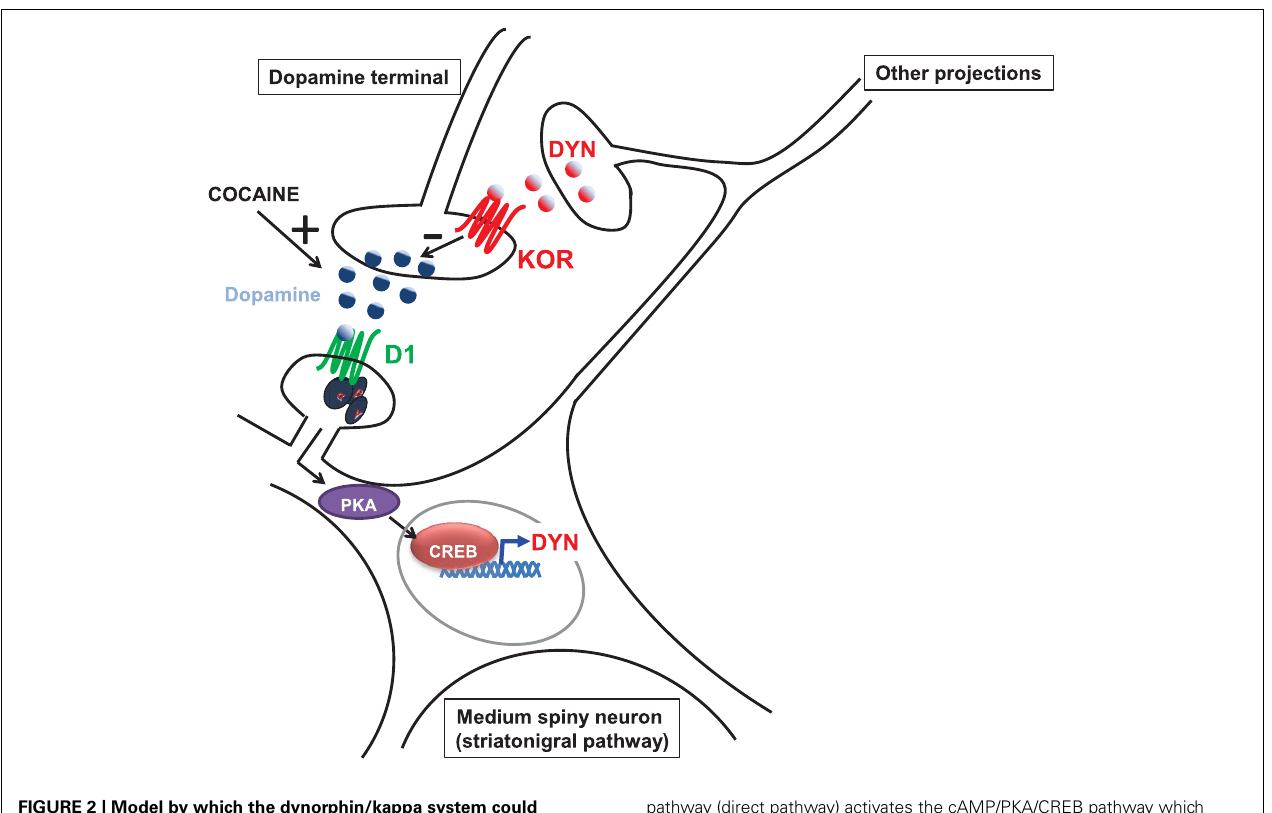
FIGURE 2 | Model by which the dynorphin/kappa system could counteract cocaine-induced dopamine release . Cocaine administration elevates dopamine levels. Binding of dopamine on the D1 receptor expressed by medium spiny neurons from the striatonigral